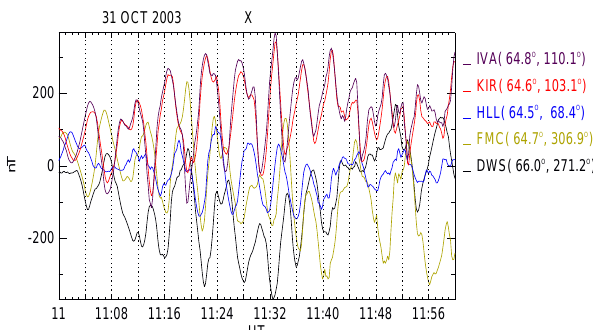
Fig. 6. The detrended magnetograms ( X component) of global Pc5 waves recorded by longitudinal profile at 8 ∼ 65 ◦ : IVA ( 3 = 110.1 ◦ ) – KIR ( 3 = 103.1 ◦ ) – HLL ( 3 = 68.4 ◦ ) – FMC ( 3 = 306.9 ◦ ) – DWS ( 3 = 271.2 ◦ ) during the time interval 11:00–